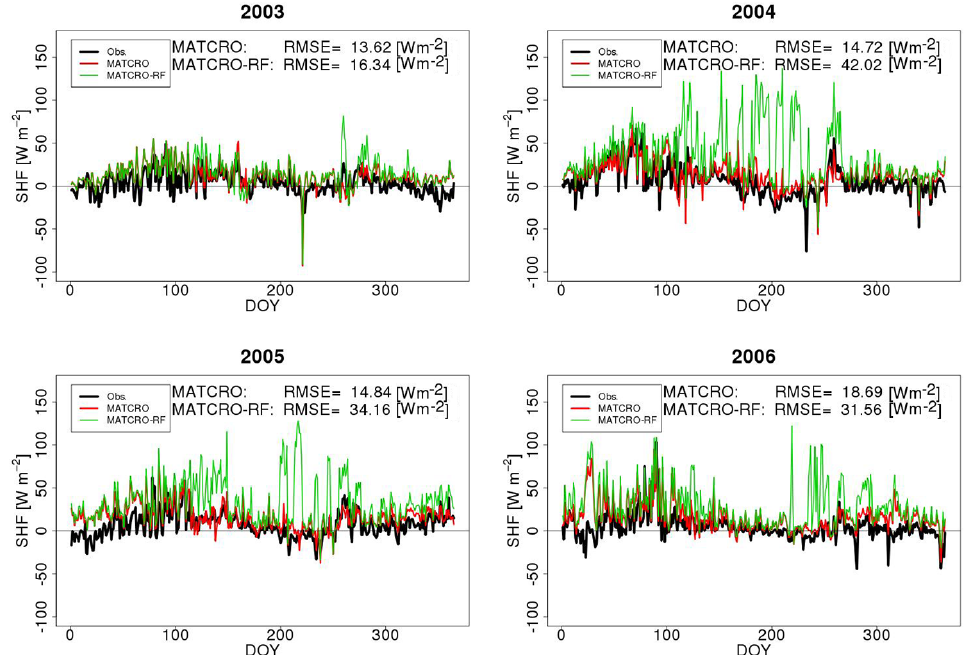
Figure 16. Comparison of SHF between observations and simulations by MATCRO and MATCRO-RF. DOY indicates the number of days from 1